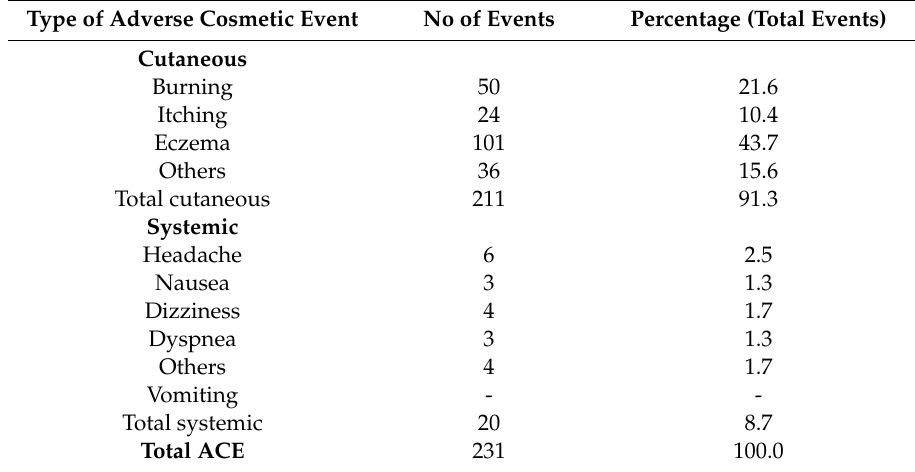
Table 3. Type and number of adverse cosmetic events.